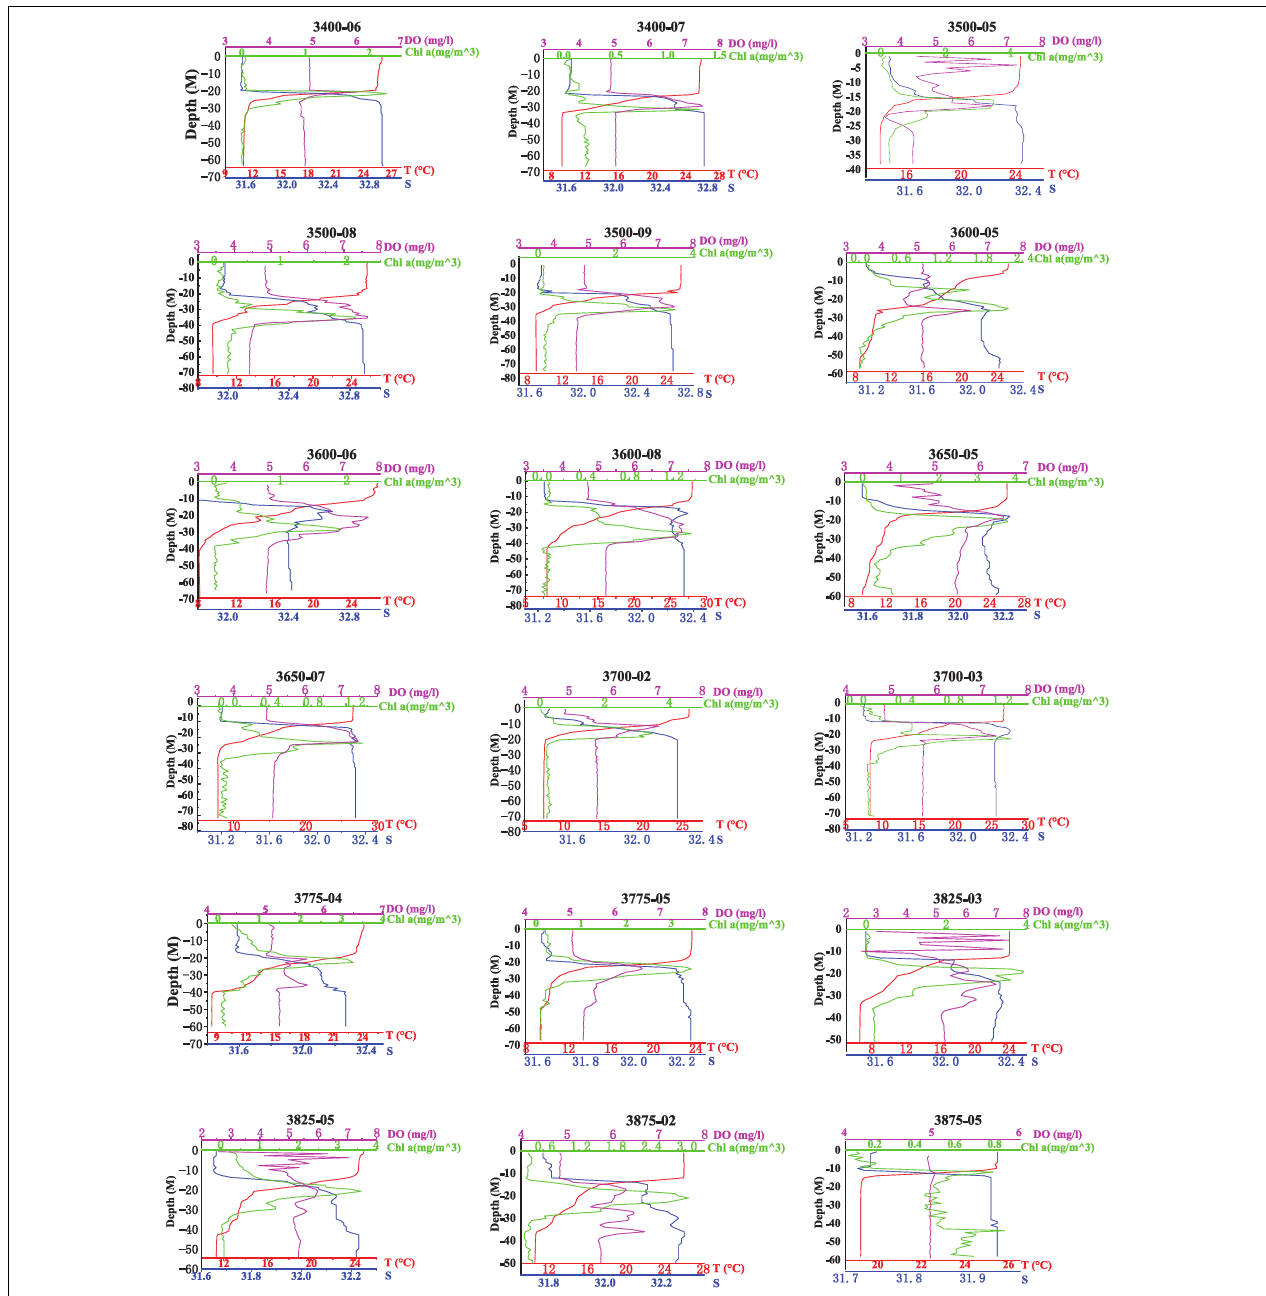
FIGURE 2 | Profiles of temperature, salinity, concentration of DO, and the fluorescence value generated by the probes at 18 VPR stations in the Yellow